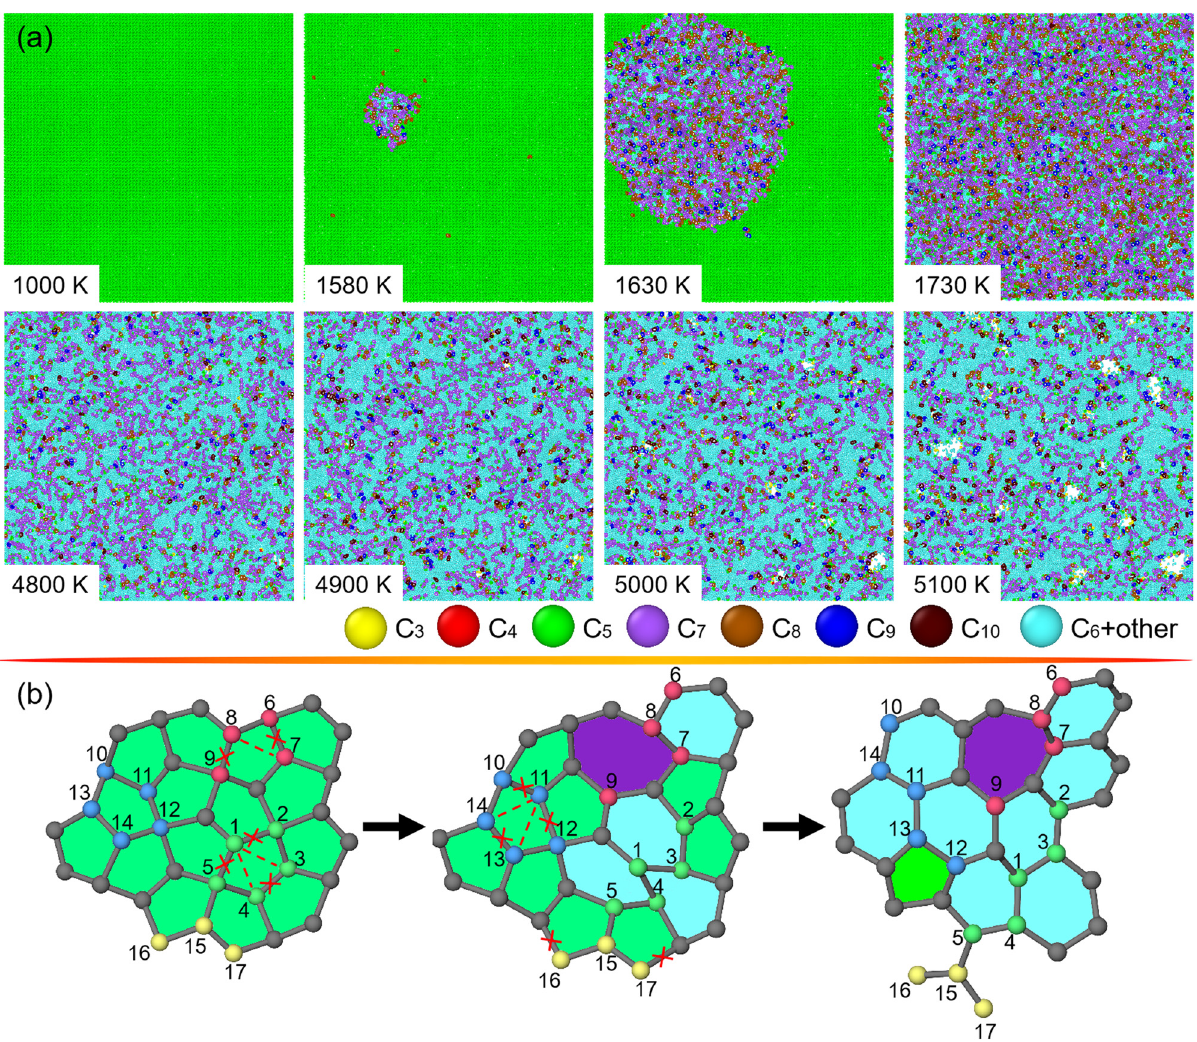
Figure 6: Structural changes in penta - graphene subjected to heating. ( a ) Top views of penta - graphene at T varying from 1,000 to 5,100 K. For clari fi cation of microstructural changes, carbon atoms in recognized polygonal rings from trigon to decagon are di ff erently rendered. ( b ) Atomic illustration of nucleation of hexagon and heptagon from pentagon in the local region of penta - graphene, in which carbon atoms are number - ranked for identifying the microstructural